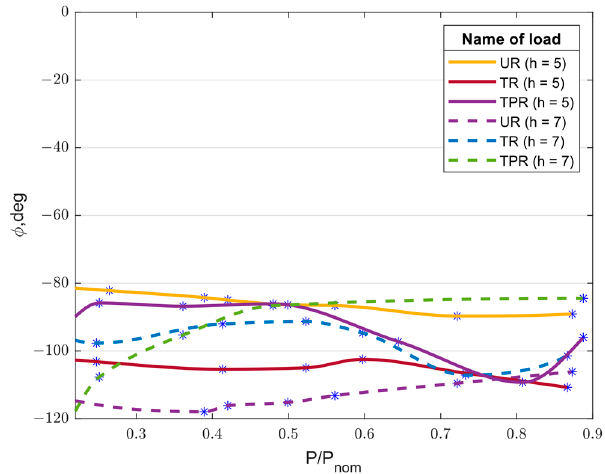
Figure 6. Phase shift angles at 5th and 7th harmonics for UR, TR and TPR.